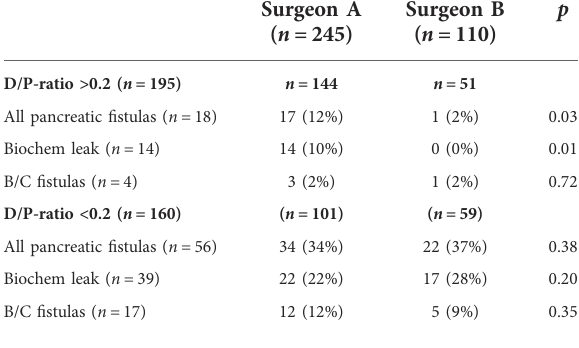
TABLE 4 Risk of POPF for ADAM anastomosis comparing two surgeons ( n =355).